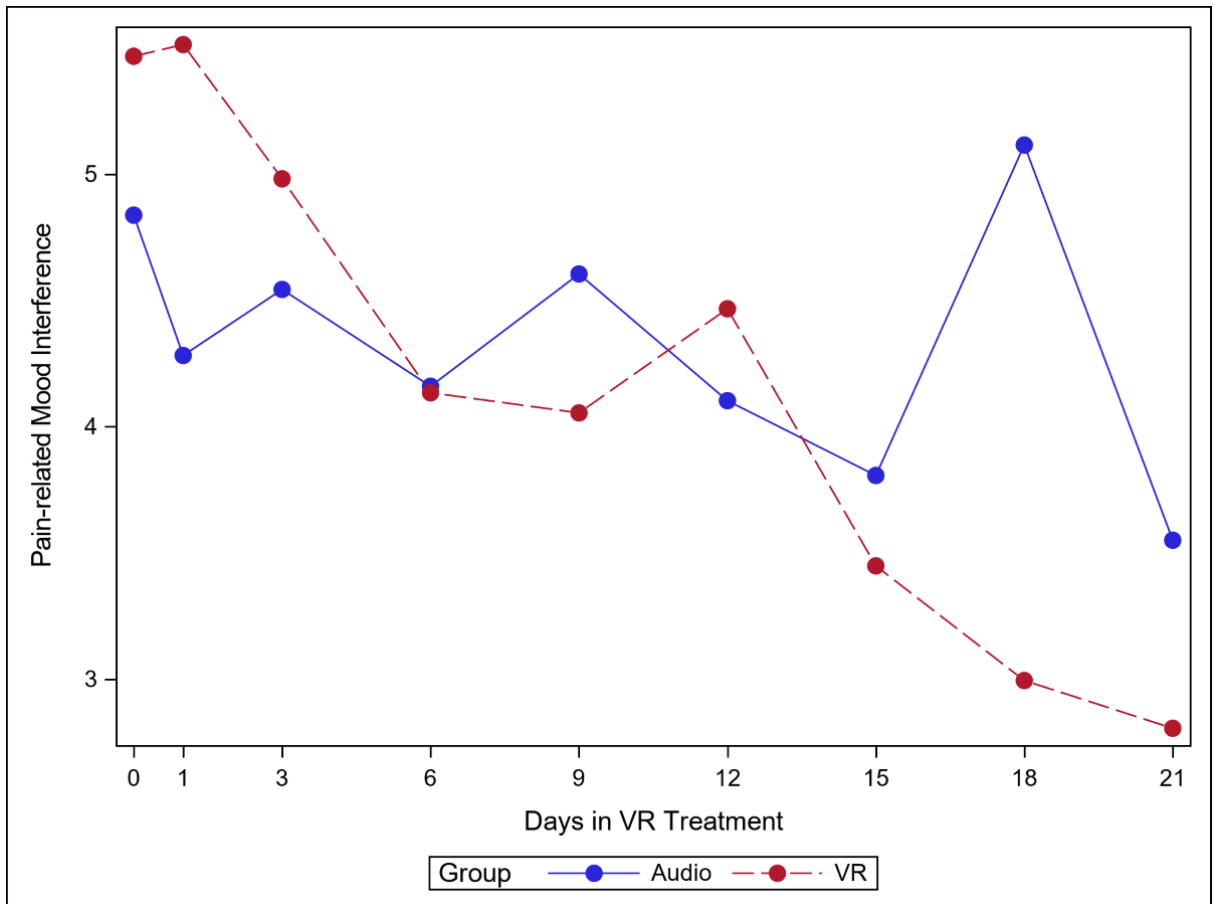
Figure 6. Effect of virtual reality vs audio on pain-related mood interference over time.